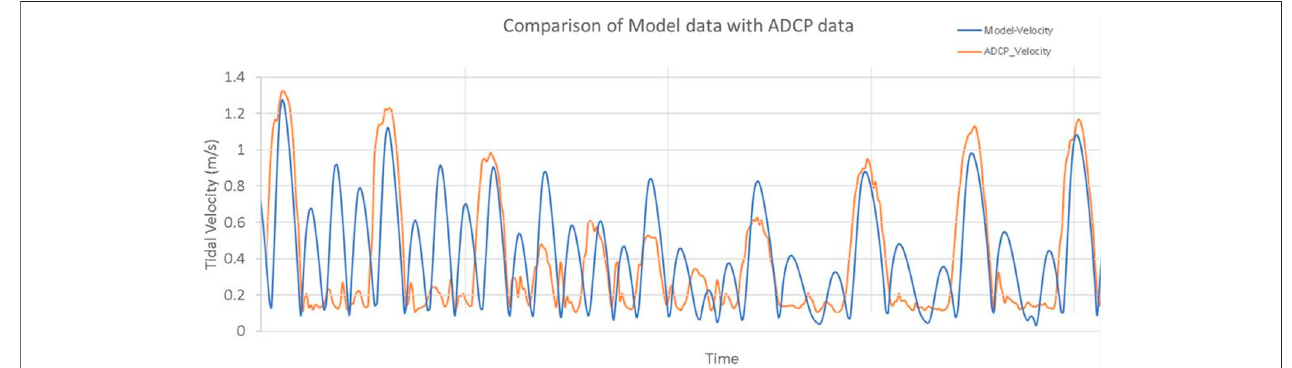
FIGURE 14 | Comparison of model data with ADCP data for tropical